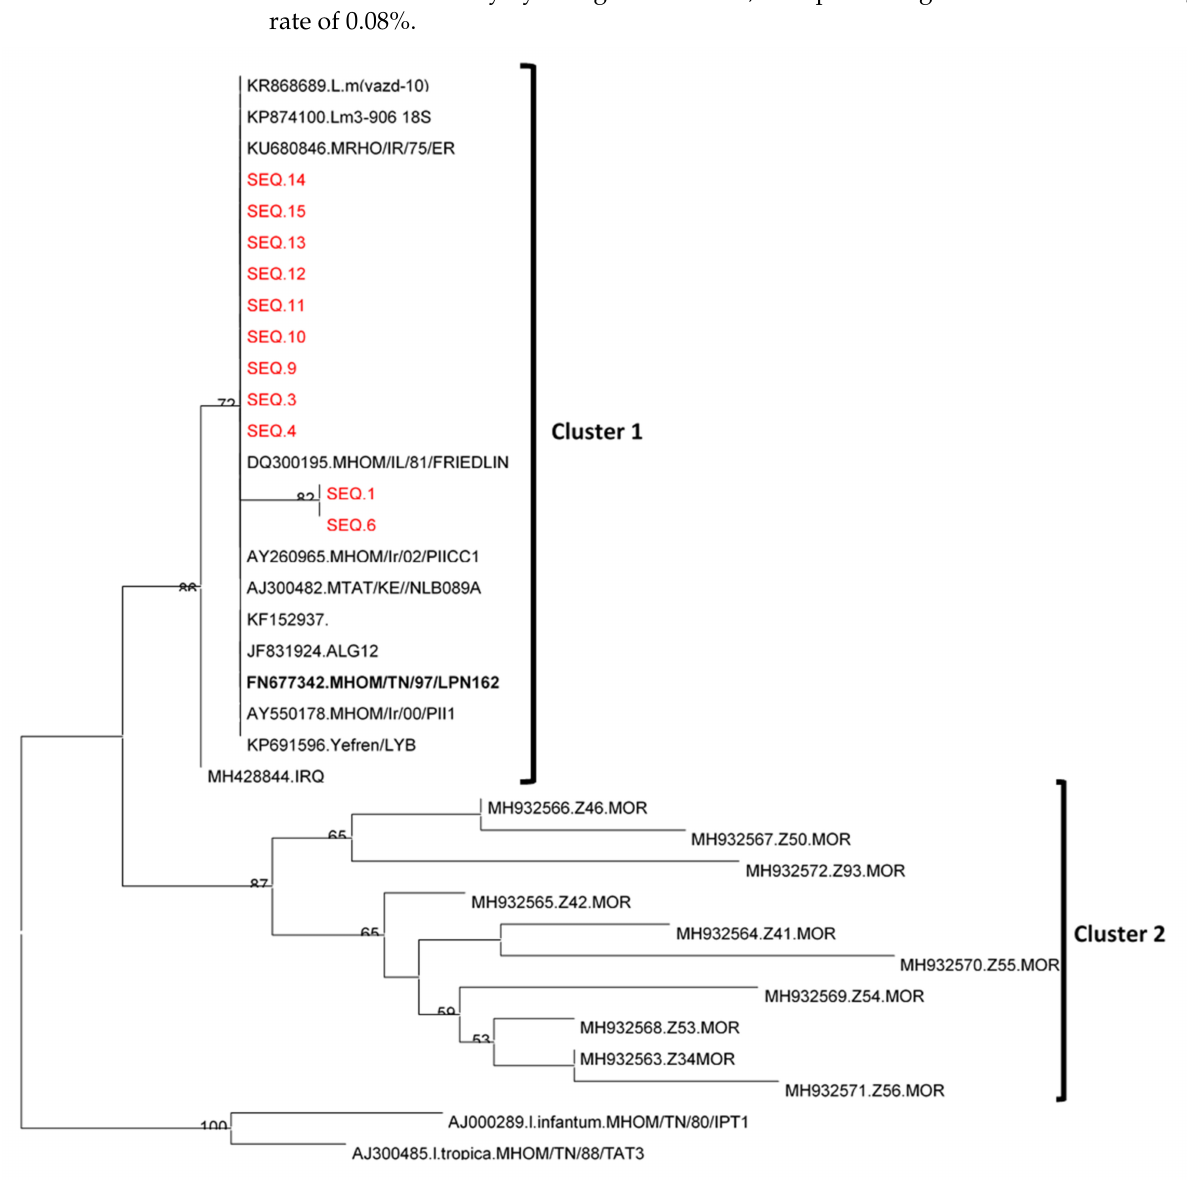
Figure 4. Phylogenetic tree based on partial Leishmania ITS-rDNA 5.8 s sequences. The tree includes 35 Leishmania ITS-rDNA 5.8 s sequences distributed as follows: 11 L. major sequences reported in this study, 22 previously published L. major sequences, and two representative sequences of L. infantum and L. tropica species. The phylogenetic tree was generated from the alignment of a 277 bp fragment of the ITS-rDNA obtained from the trimming of the sequences used, followed by maximum likelihood model analysis using Jukes–Cantor parameter. The tree topology was supported by 1000 bootstrap replicates, and bootstrap values lower than 50 were